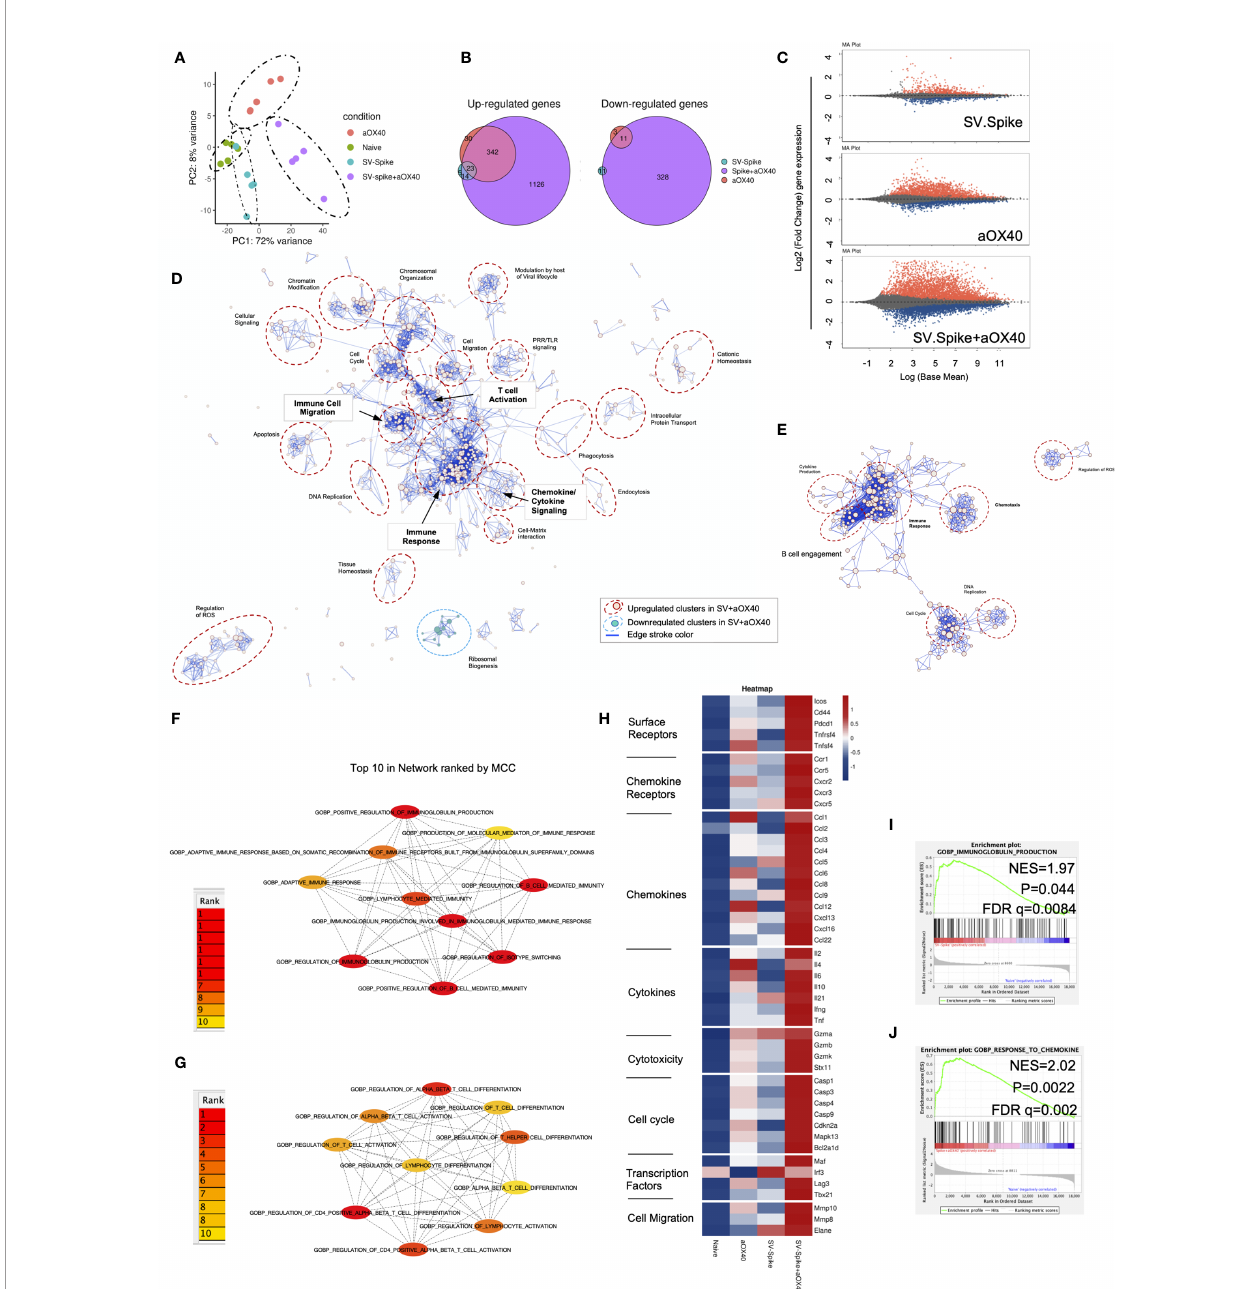
FIGURE 6 | Sindbis expressing SARS-CoV-2 spike+ a OX40 C57BL/6J vaccinated mice are characterized by a unique transcriptional signature of T cells. Combination therapy markedly changes the transcriptome signature of T cells favoring T-cell differentiation towards effector T-cells with a Th1 type phenotype 7 days after prime vaccination. (A) Principal component analysis (PCA) of RNA seq data from naïve, SV.Spike, and/or a OX40 groups. (B) Venn diagrams summarizing the overlap between differentially expressed genes (DEGs) from SV.Spike (blue), a OX40 (pink), and SV.Spike+ a OX40 (purple). Up-regulated DEGs (left) and down- regulated (right). (C) MA plots of differentially expressed genes in T-cells of naive versus SV.Spike (top graph), a OX40 (middle graph), and combination (bottom graph). Signi fi cantly (p<0.05) upregulated and downregulated DEGs are depicted in red or blue, respectively. (D) Pathway and network analysis based on GSEA in T-cells isolated from mice treated with combination therapy. Downregulated (blue circle) and upregulated (red circles) pathways are shown, respectively. (E) Pathway and network analysis based on GSEA in T-cells isolated from mice treated with single dose of SV.Spike. Top 10 hub biological process gene ontology (GO) terms ranked by the Cytoscape plugin cytoHubba (red, highest ranks; yellow, lowest ranks) in the SV.Spike only (F) versus combination immunized group (G) . Heatmap analysis of selected genes based on normalized read counts linked to T-cell differentiation in the SV.Spike and/or a OX40 immunized mice compared to naïve (H) . Highlighted selected gene set enrichment analysis (GSEA) pathways based on DEG in naive versus SV.Spike (I) and combination treated group (J)